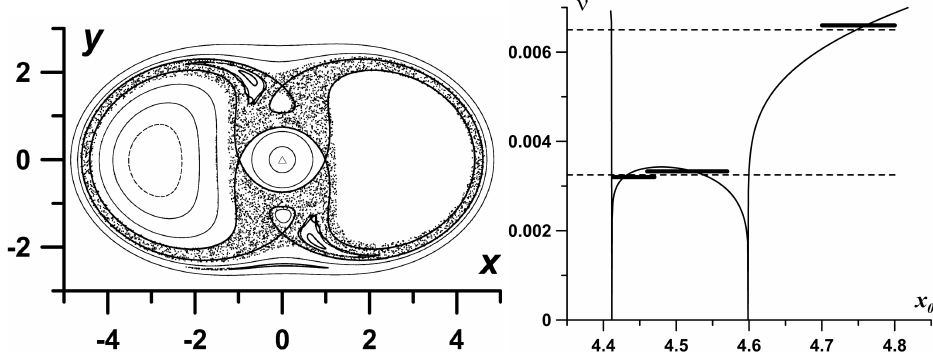
Figure 8. A Poincaré map for the perturbed the system in Equation (49) (perturbation magnitude ε = 0.01, and frequency ν = 0.0065) demonstrating the manifestation of stability islands corresponding to a nonlinear resonance 1 : 2. The solid bold lines show the corresponding steady-state